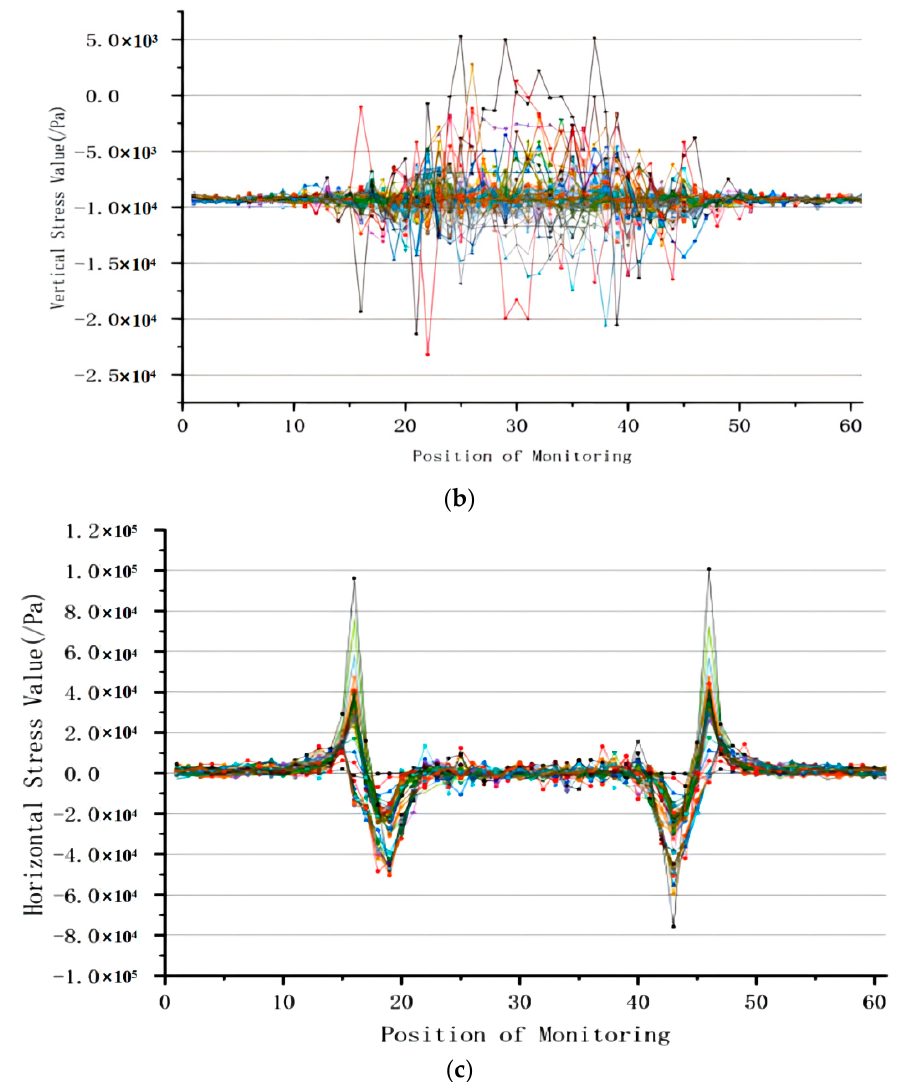
Figure 7. Characteristic analysis curve of surface movement and deformation. ( a ) Surface subsidence characteristic curve; ( b ) Characteristic of surface vertical stress distribution curve; ( c ) Characteristic of surface horizontal stress distribution curve.